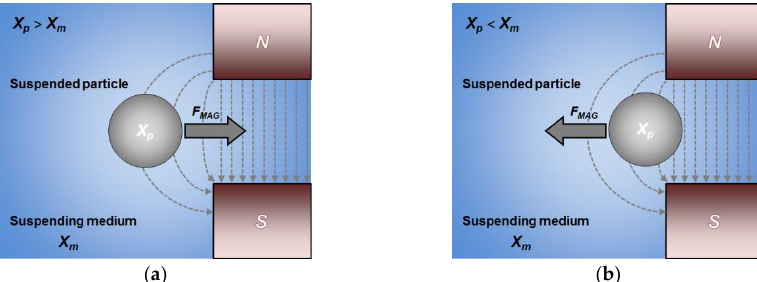
Figure 4. Magnetophoretic motion of a magnetic particle in a non-uniform magnetic field. ( a ) Positive magnetophoresis in which a magnetic particle migrates toward a higher magnetic field region. ( b ) Negative magnetophoresis in which a magnetic particle moves to a lower magnetic field region. Reproduced from [40], with the permission of AIP Publishing (2012).